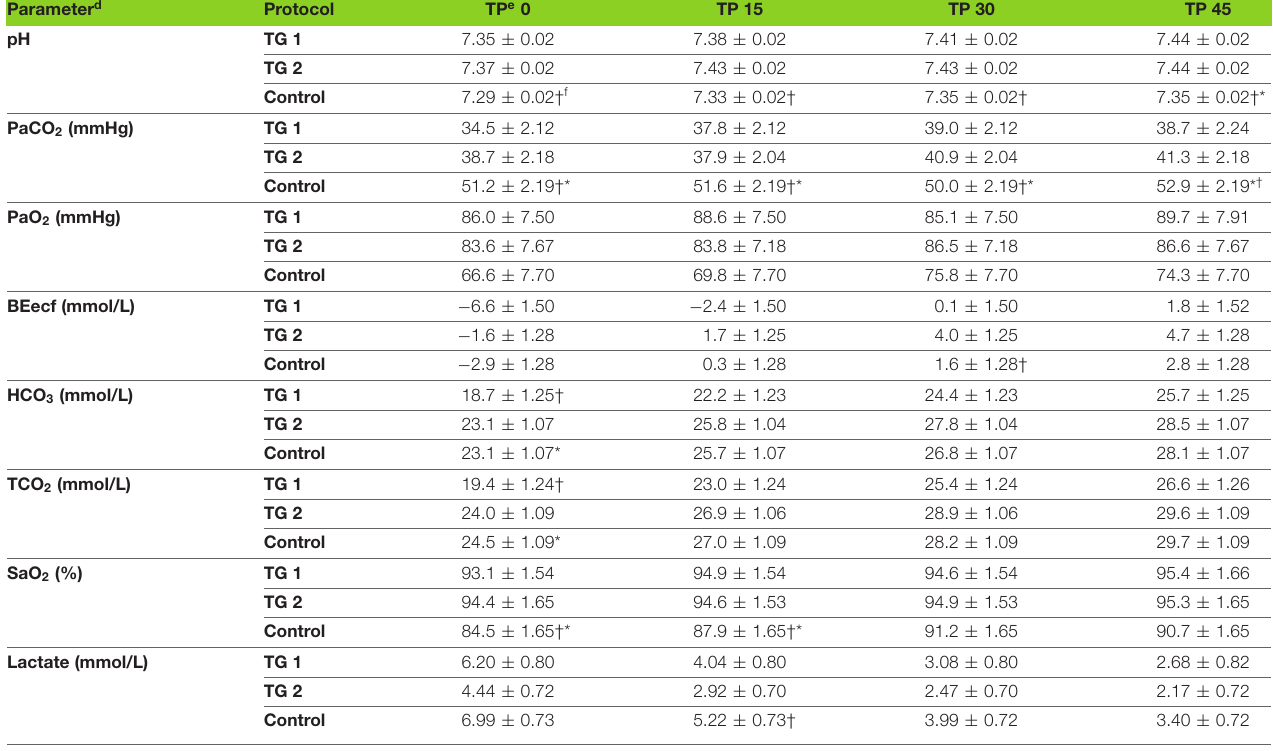
TABLE 7 | Blood gas parameters of TG a 1: ketamine–medetomidine–midazolam–butorphanol (KMMB), TG 2: tiletamine–zolazepam–medetomidine–butorphanol (TZMB), and CG b : etorphine–acepromazine–detomidine–butorphanol (EADB), immobilized kulans (Equus hemionus kulan) following recumbency at timepoint 0 for a 45-minute